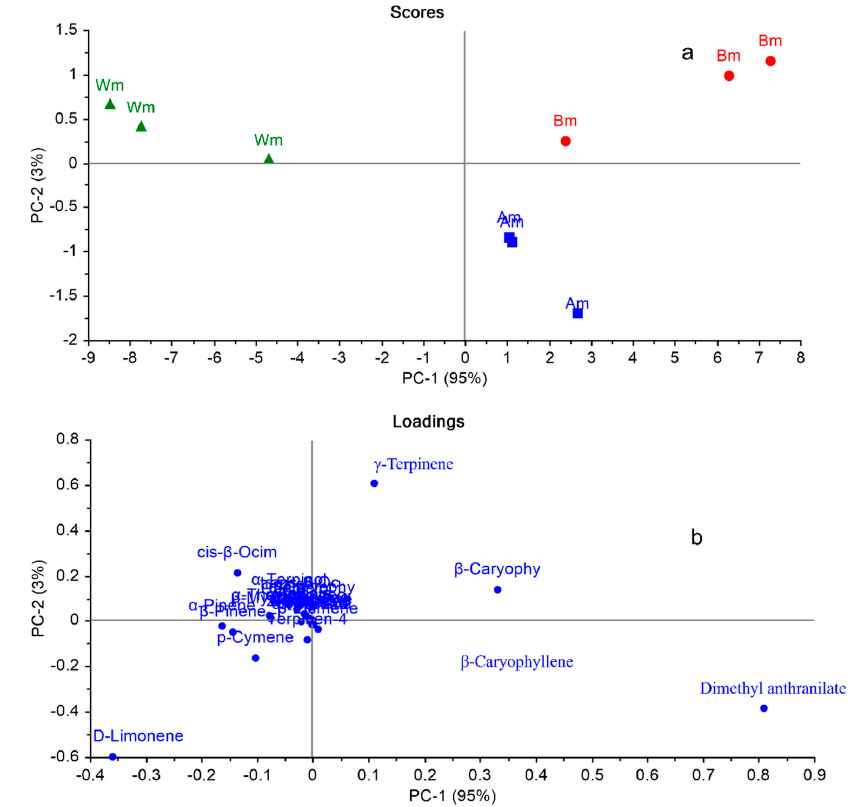
Figure 2. PCA score plot ( a ), loading plot ( b ) based on GC ‐ MS metabolic profiles of Am, Bm, and 1 for cultivar